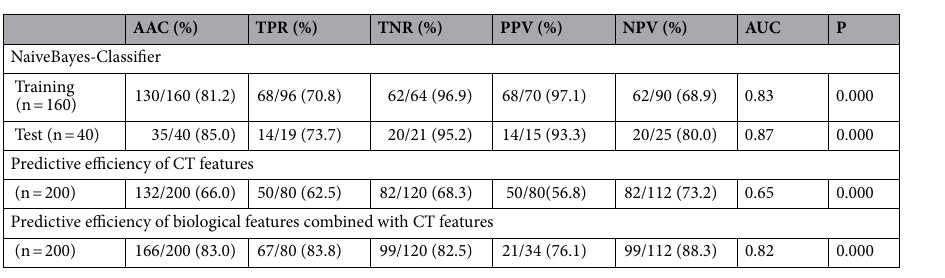
Table 3. Confusion matrix results of machine learning classification, CT only classification and clinical CT